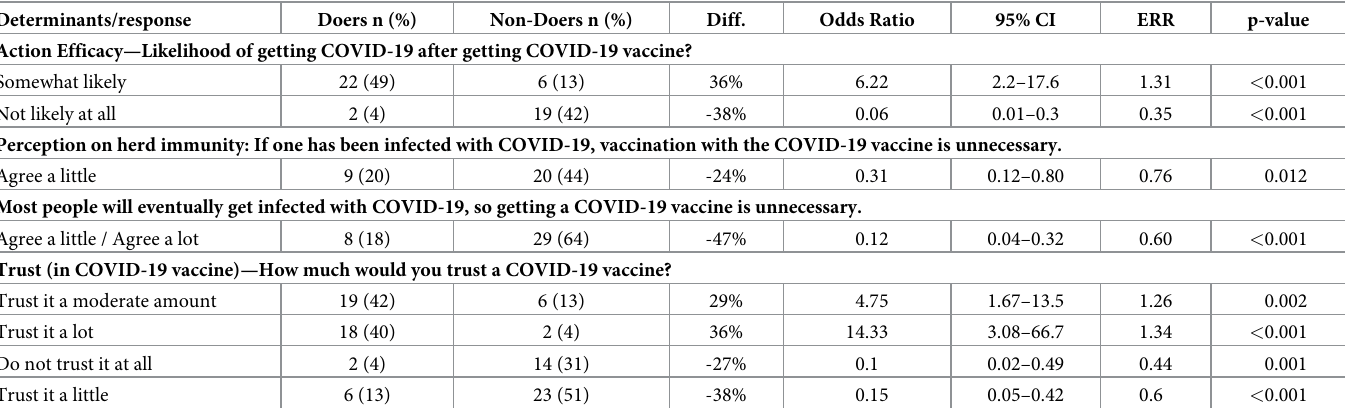
Table 6. Perceived action efficacy and trust in COVID-19